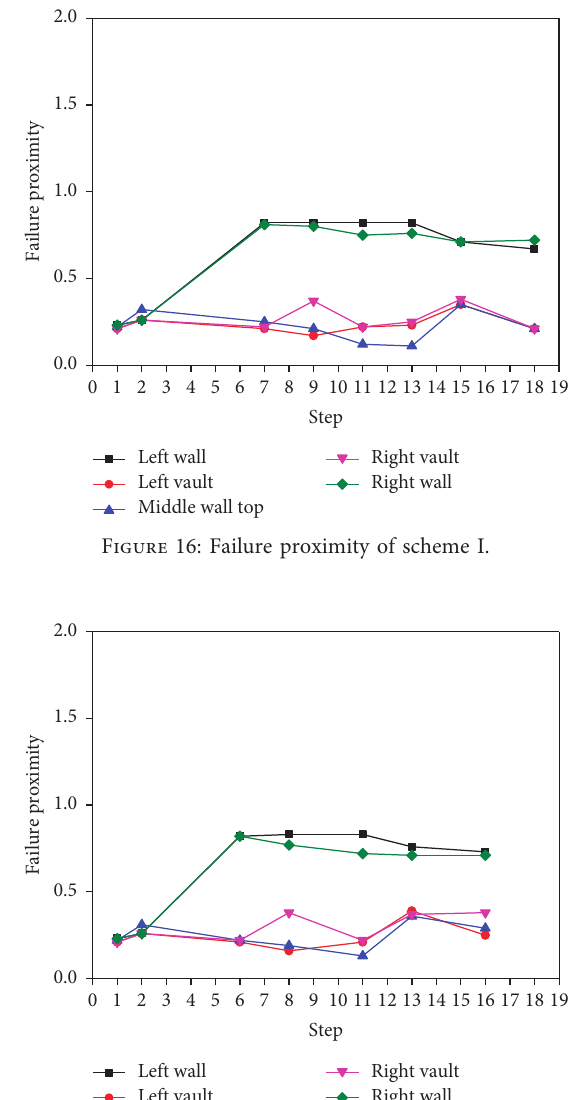
Middle wall top: the surrounding rock here is relatively Right vault: the surrounding rock here is relatively safe, Left wall: during the construction of the middle pilot tunnel and right tunnel, the surrounding rock is in a relatively safe range. However, with the construction of the upper and lower steps of the left tunnel, the sur- rounding rock tends to be damaged more. During the construction of the upper steps of the right tunnel, the